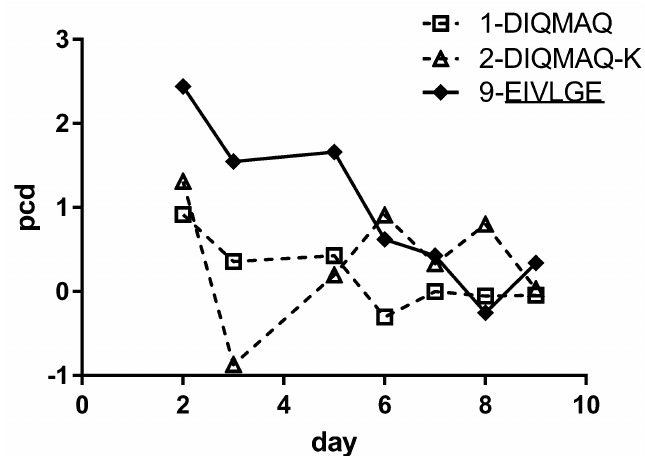
Figure 4. Specific productivity of BaxM159 variants at 10 L bioreactor scale. Specific productivity pcd is calculated as pcd = (pg × cell − 1 × day − 1 ). IgG titer of the 10 L bioreactor scale experiment is shown in the Supplementary Figure S2.